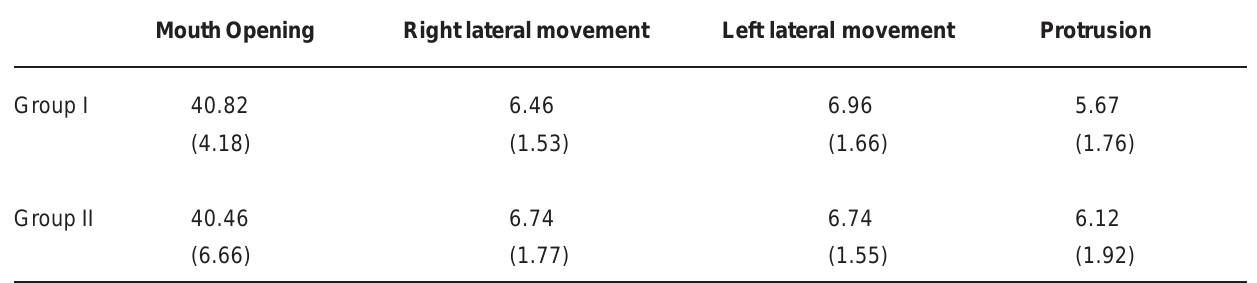
Student t test p>0.05